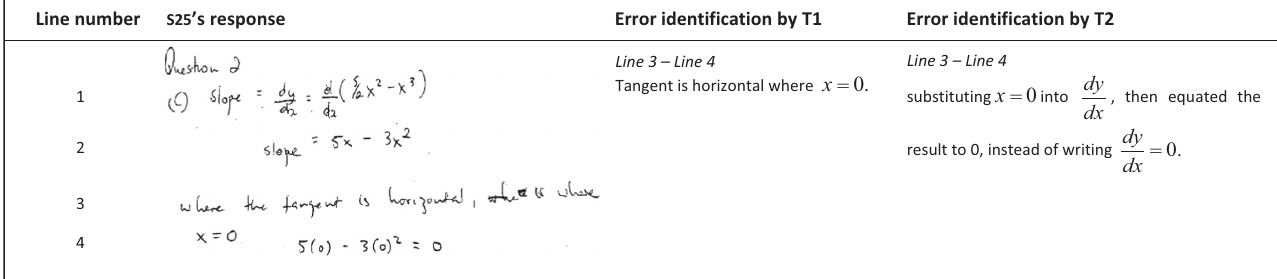
FIGURE 4: Error identification in S25’s